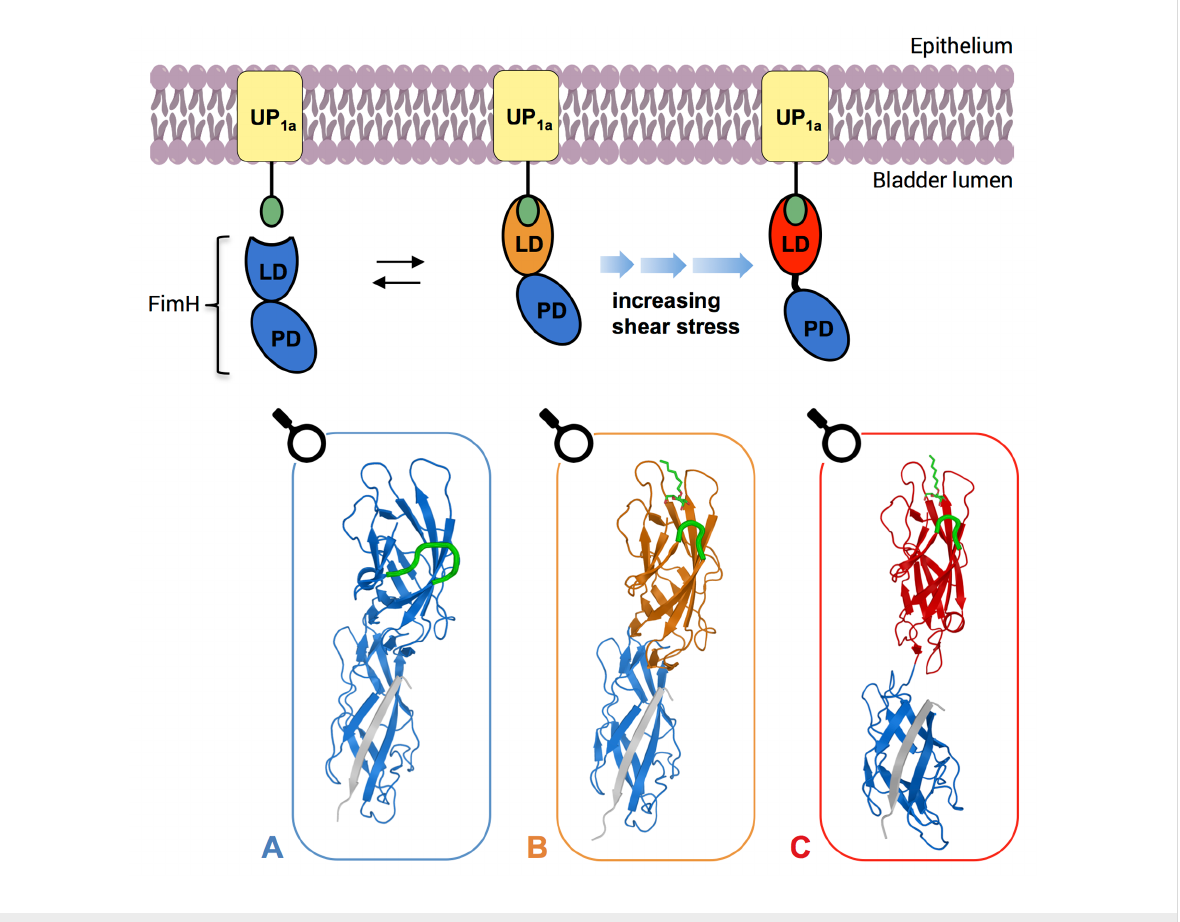
Figure 7: Schematic overview of the conformational changes of FimH ( I ). FimH crystal structures, which correspond to each individual state are shown in boxes. In the absence of urine flow FimH is in the low-affinity conformation, characterized by an open binding pocket and intertwined domains (A, PDB: 4XOD). Upon ligand binding, FimH adopts the medium-affinity conformation (B, PDB: 4XOE), in which a loop (highlighted in green in the crystal structures) closes in the ligand, forming a deep and well-defined binding pocket. As urine begins to flow, the two domains are pulled apart, inducing the high-affinity conformation (C, PDB: 4XOB). LD, lectin domain; PD, pilin domain [72].